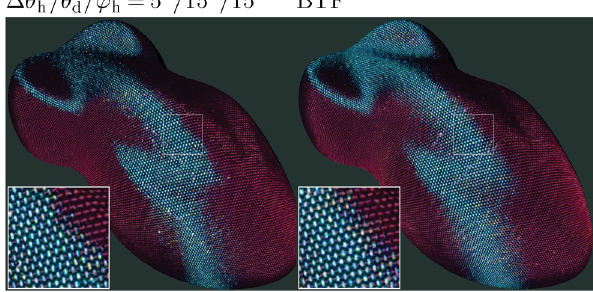
An extension of the bivariate isotropic representation to measurement of anisotropic materials by a sampling along ϕ h represented by 1992 images (left), compared to a standard uniform BTF using 6561 images